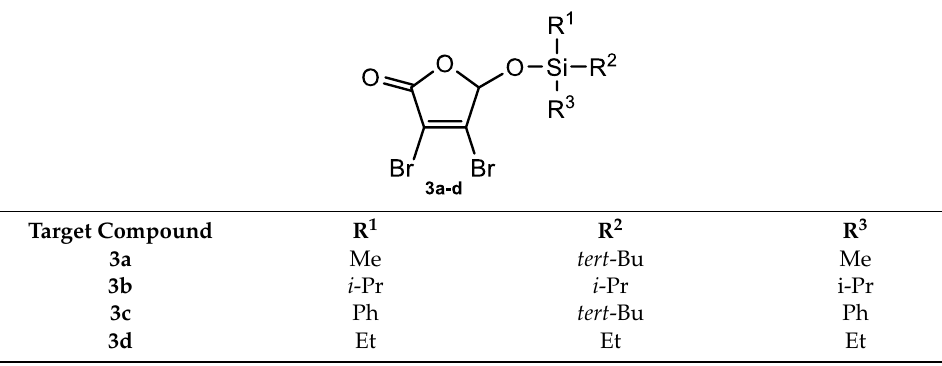
Table 1. 5- O -Silyl ethers of MBA.